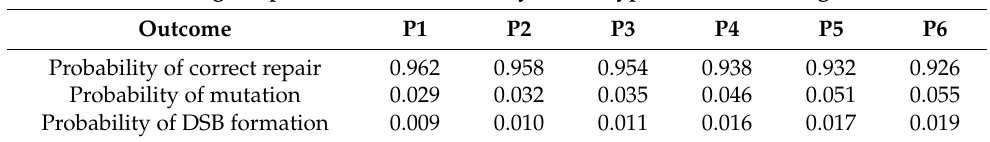
Table 5. The average repair outcome probability for all types of DNA damage for cells irradiated by a 62 MeV proton beam for LP BER pathway.